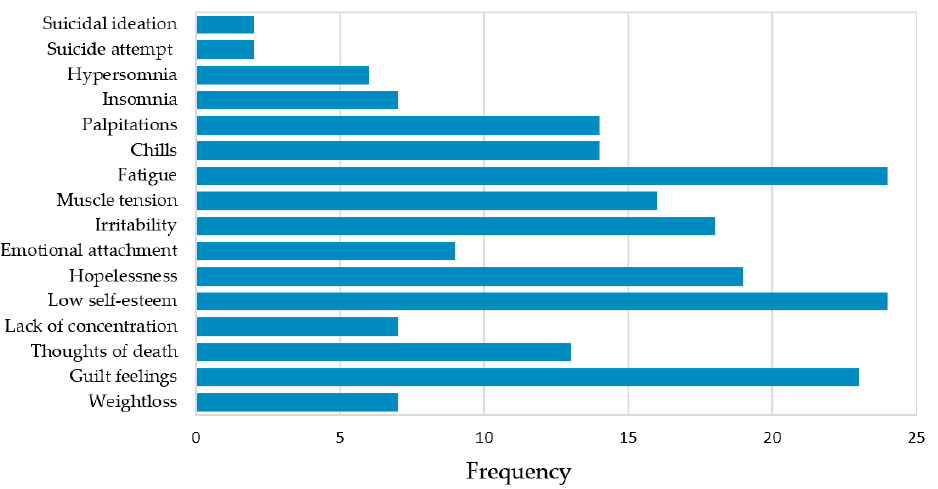
Table 1. Description of triggering factors for anxiety and/or depression by social area.